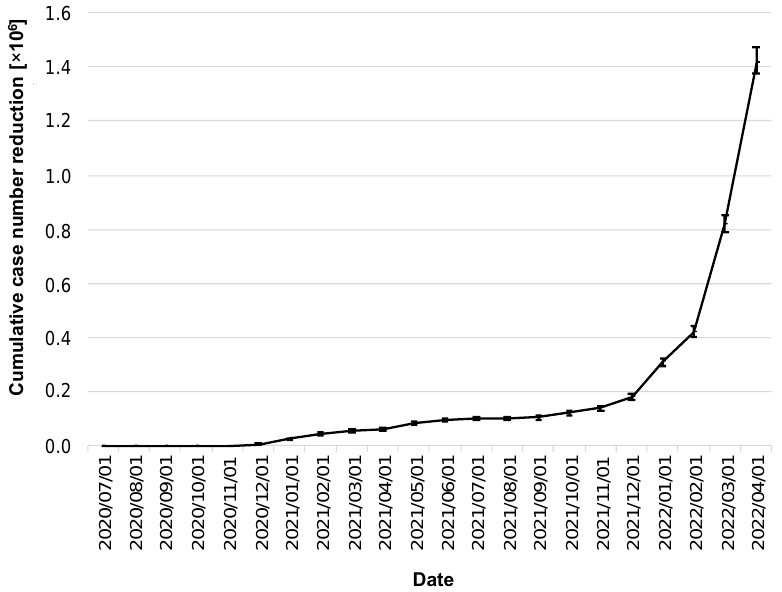
Figure 5. Cumulative reduction of infection cases by the CWA. Data in millions of cases. The error bars indicate the 95% confidence intervals.